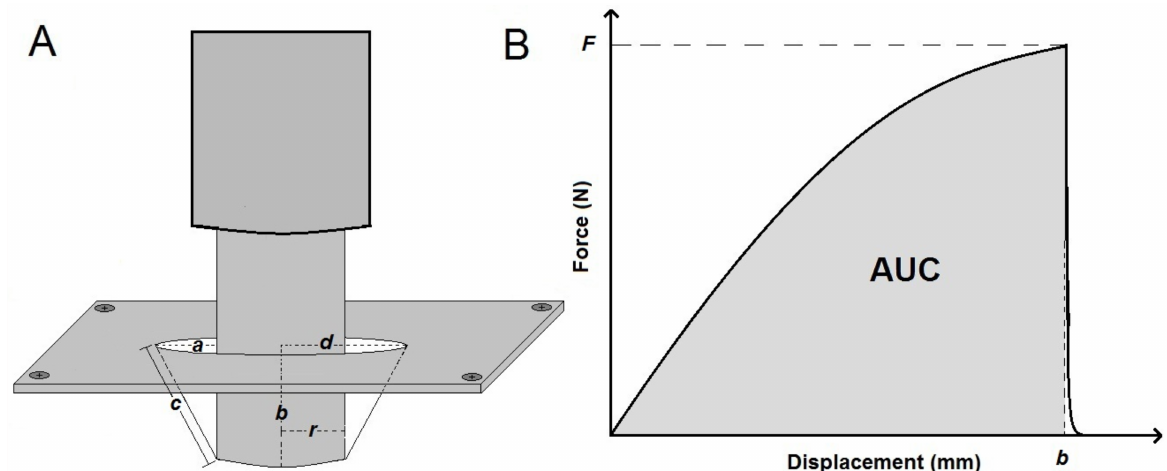
Figure 1. ( A ) Determination of elongation to break: sample deformation before break ( d = radius of the rice starch film in the sample holder opening (initial length); a = initial length − radius of probe; b = displacement of the probe; c + r = length after strain; c = length of a after strain; and r = radius of probe). ( B ) Typical plot of force versus displacement for films subjected to puncture. F is the force required to puncture the film, and b is the distance at